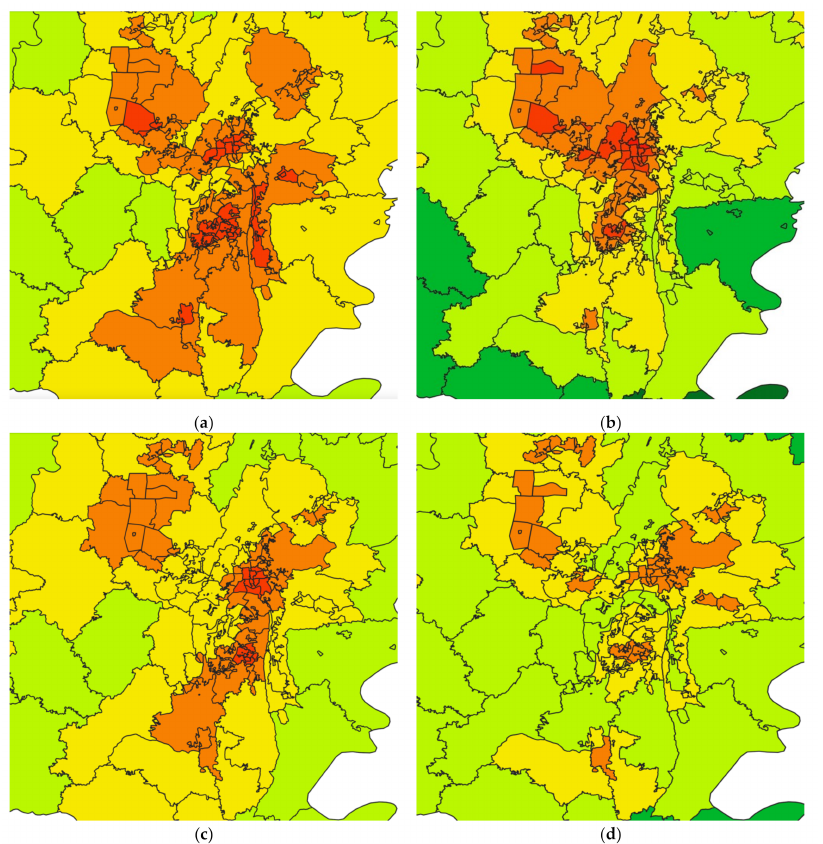
Figure 8. Visualization map of urban regional vehicle density in downtown areas of Guiyang. ( a ) Traffic conditions at 8 o’clock. ( b ) Traffic conditions at 12 o’clock. ( c ) Traffic conditions at 18 o’clock. ( d ) Traffic conditions at 22